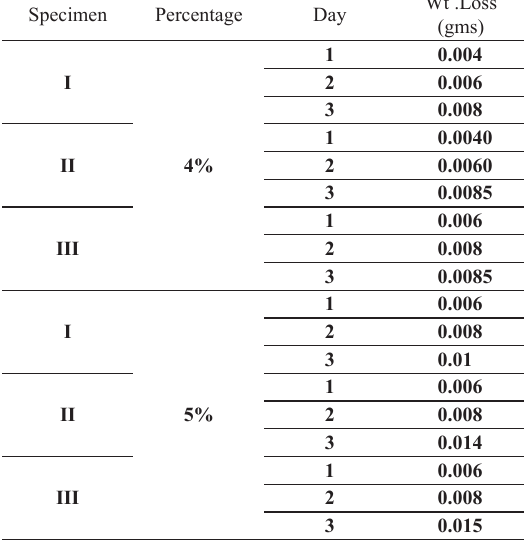
Table 5. Wieght Loss